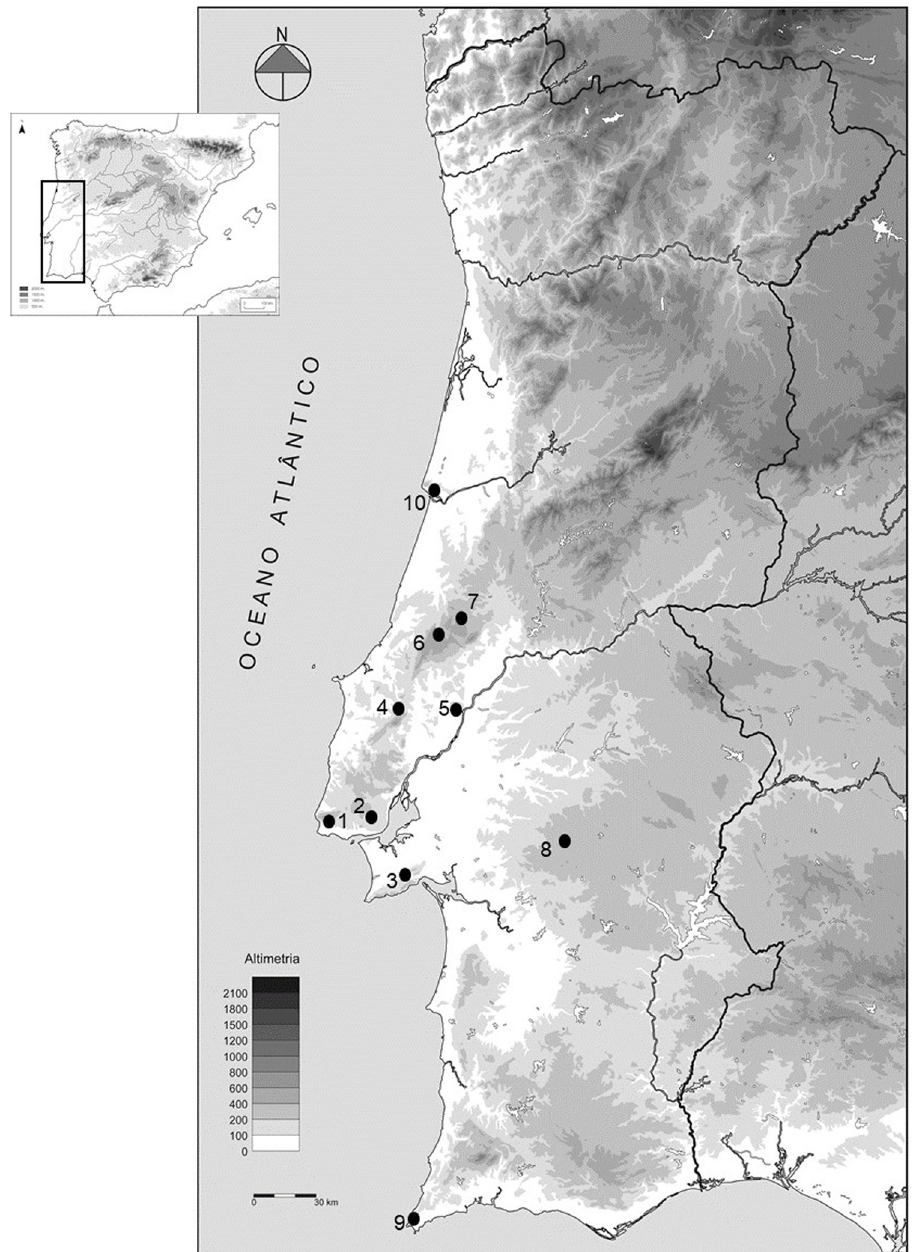
Figure 2: Iberian Peninsula and Portugal main sites mentioned in the text: ( 1 ) São Pedro de Canaferrim and Lameiras ( Sintra ) , ( 2 ) Correio - Mor cave ( Loures ) , ( 3 ) Lapa do Fumo cave ( Sesimbra ) , ( 4 ) Nossa Senhora da Luz ’ cave ( Rio Maior ) , ( 5 ) Santarém ( Santarém ) , ( 6 ) Almonda Spring cave ( Torres Novas ) , ( 7 ) Caldeirão cave ( Tomar ) , ( 8 ) Valada do Mato ( Évora ) , ( 9 ) Cabranosa ( Sagres ) , and ( 10 ) Junqueira e Várzea do Lírio ( Figueira da Foz ) . Cartography after Trabajos de Prehistoria and Boaven - tura ( 2009 )